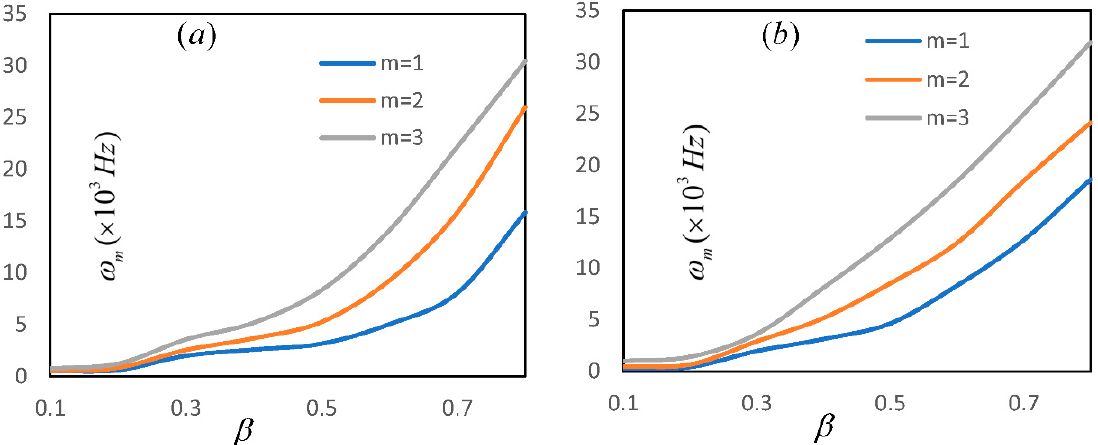
β of two-layered annular